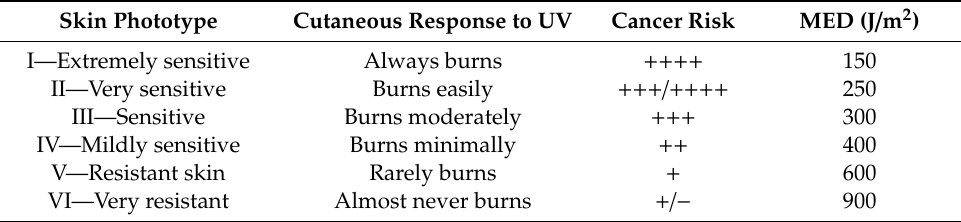
Table 1. Skin phototypes and related cutaneous responses to UV, cancer risks and